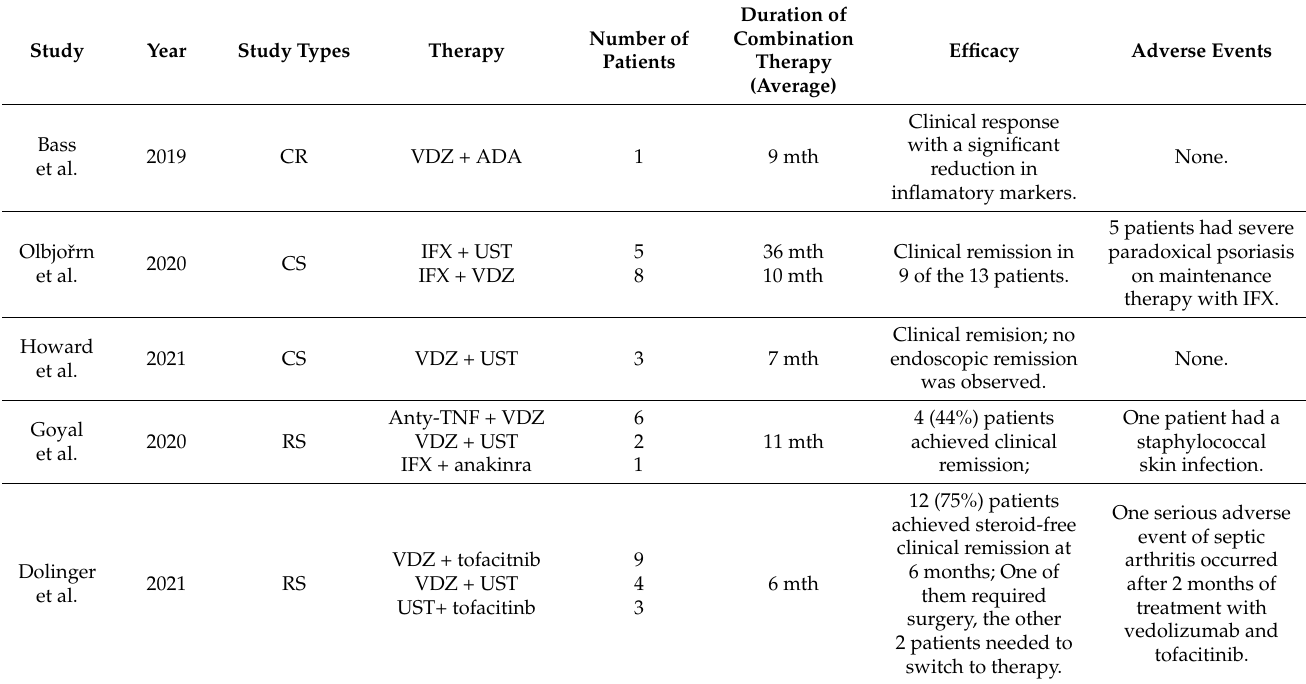
Table 1. A Review of the literature on dual biologics for the treatment of pediatric